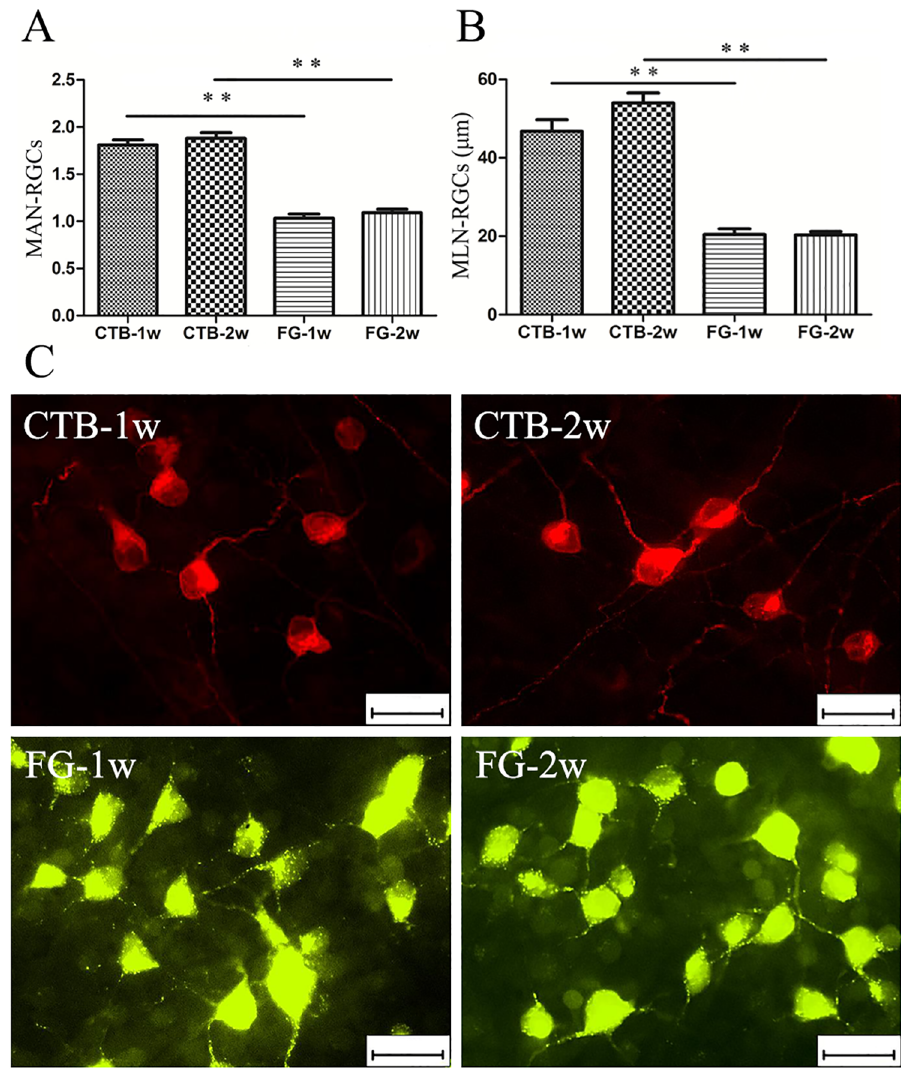
Fig 2. The morphology of cholera toxin subunit B (CTB)-retrograde labeled and Fluorogold(FG)-retrograde labeled retinal ganglion cells (RGCs) at 1 week and 2 weeks in rats. (A) The mean amount of neurites of labeled RGCs (MAN-RGCs) in CTB-1w (rats euthanized 1 week post-CTB injection) and CTB-2w (rats euthanized 2 weeks post-CTB injection) were more than those in FG-1w (rats euthanized 1 week post-FG injection) and FG-2w (rats euthanized 2 weeks post-FG injection) (p < 0.001), but there was no distinction between the CTB-1w and CTB-2w (p = 0.749) or between the FG-1w and FG-2w (p = 0.842). (B) In terms of the mean length of neurites of labeled RGCs (MLN-RGCs), The CTB-1w and CTB-2w exhibited longer labeled RGC neurites than the FG-1w and FG-2w (p < 0.001), but no difference was evident between the CTB-1w and CTB-2w (p = 0.111) or between the FG-1w and FG- 2w (p = 1.0). (C) Representative photomicrographs taken at approximately 5/6 retinal radius in the superonasal quadrant showing the neurites of RGCs labeled by CTB and FG at 1 week and 2 weeks. (cid:3)(cid:3) Two-way analysis of variance (ANOVA), p < 0.001. Scale bar = 25